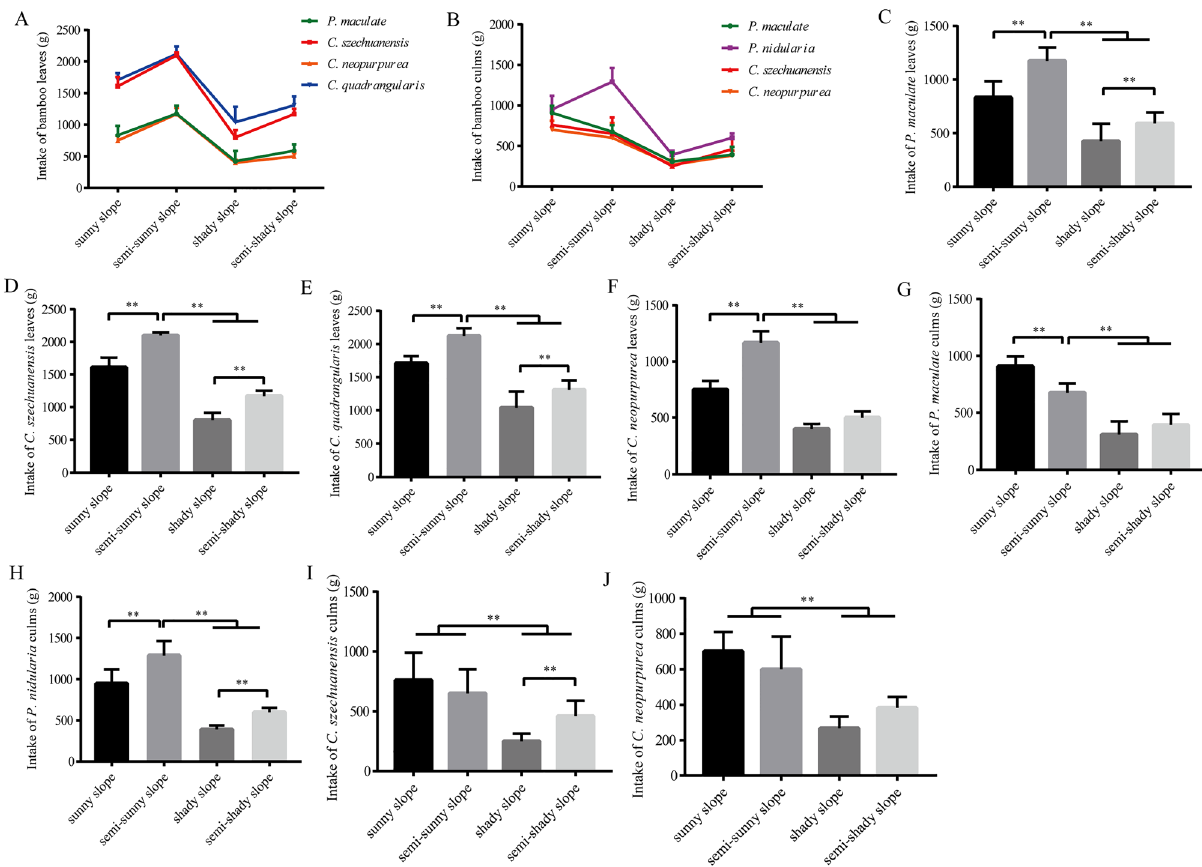
Figure 3. Feed intake of bamboo growing on different slope orientations for captive giant